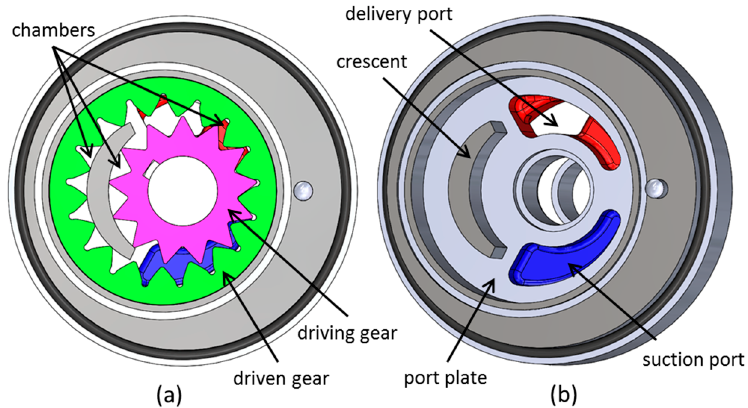
Figure 2. ( a ) Example of a crescent pump; ( b ) detail of the port plate.